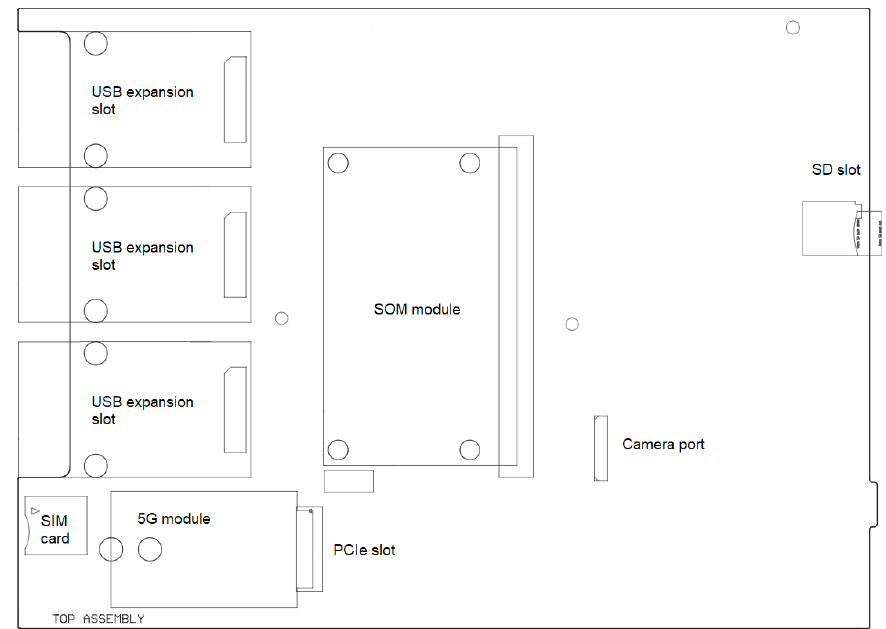
Figure 15. GWEN carrier board—top